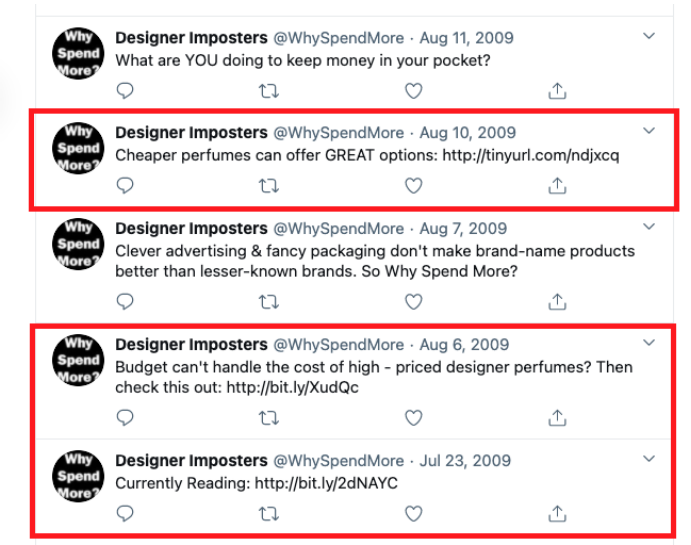
Figure 1. An example of a Twitter spam user. This user posted five tweets, but not all tweets contribute equally when we identify whether it is a spammer or a legitimate